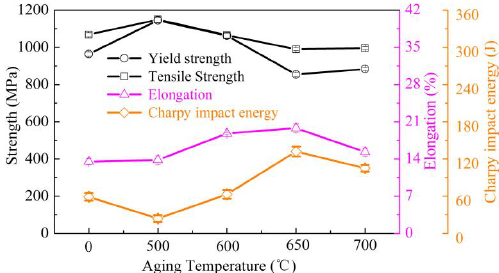
Figure 2. Variation of the mechanical properties with aging temperature of the tested steel.